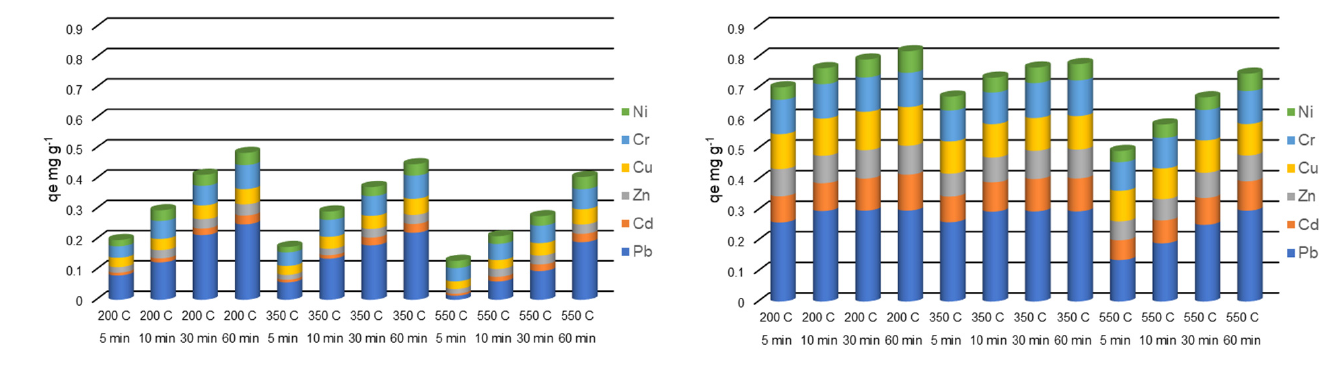
Figure 7. Amount of heavy metals in the adsorbent phase q e (mg g − 1 ) with a grain size of 1- mm ( a ), and 0–0.05 mm ( b ), thermally treated adsorbed from multicomponent solutions of 30 mg L − 1 at four different contact times (5, 10, 30, 60 min).